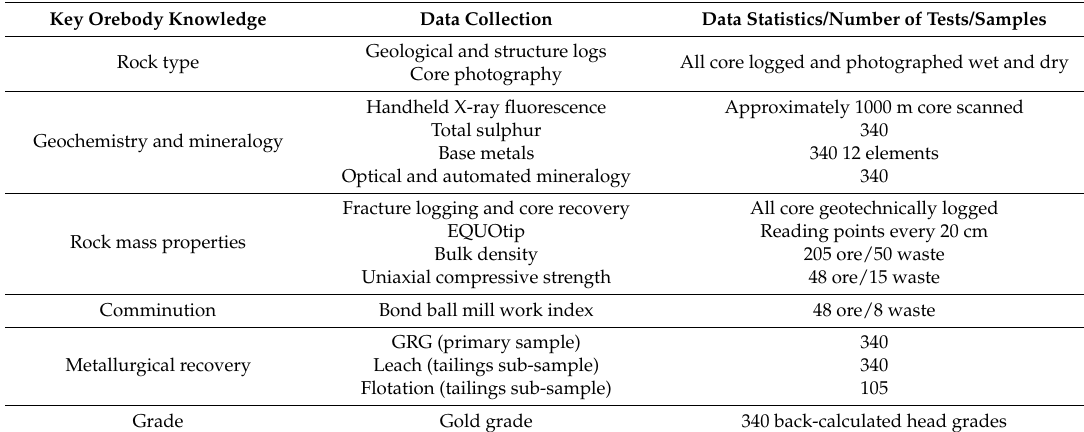
Table 4. Summary of data collected during the geometallurgical drilling programme.